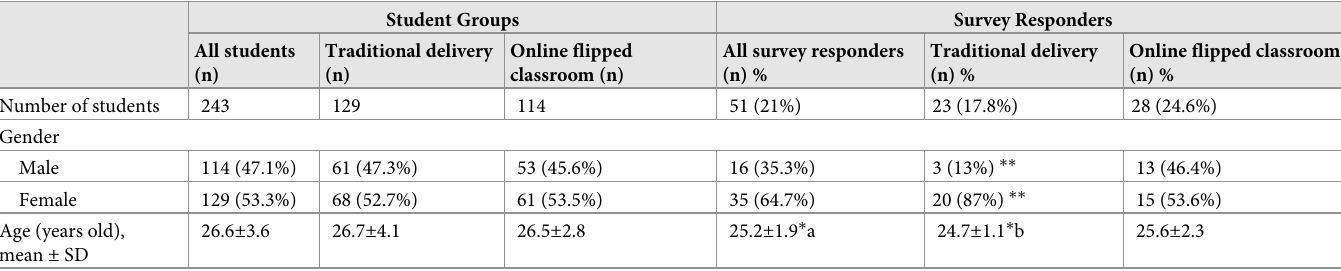
Table 2. Demographic information of students who participated in traditional delivery and online flipped